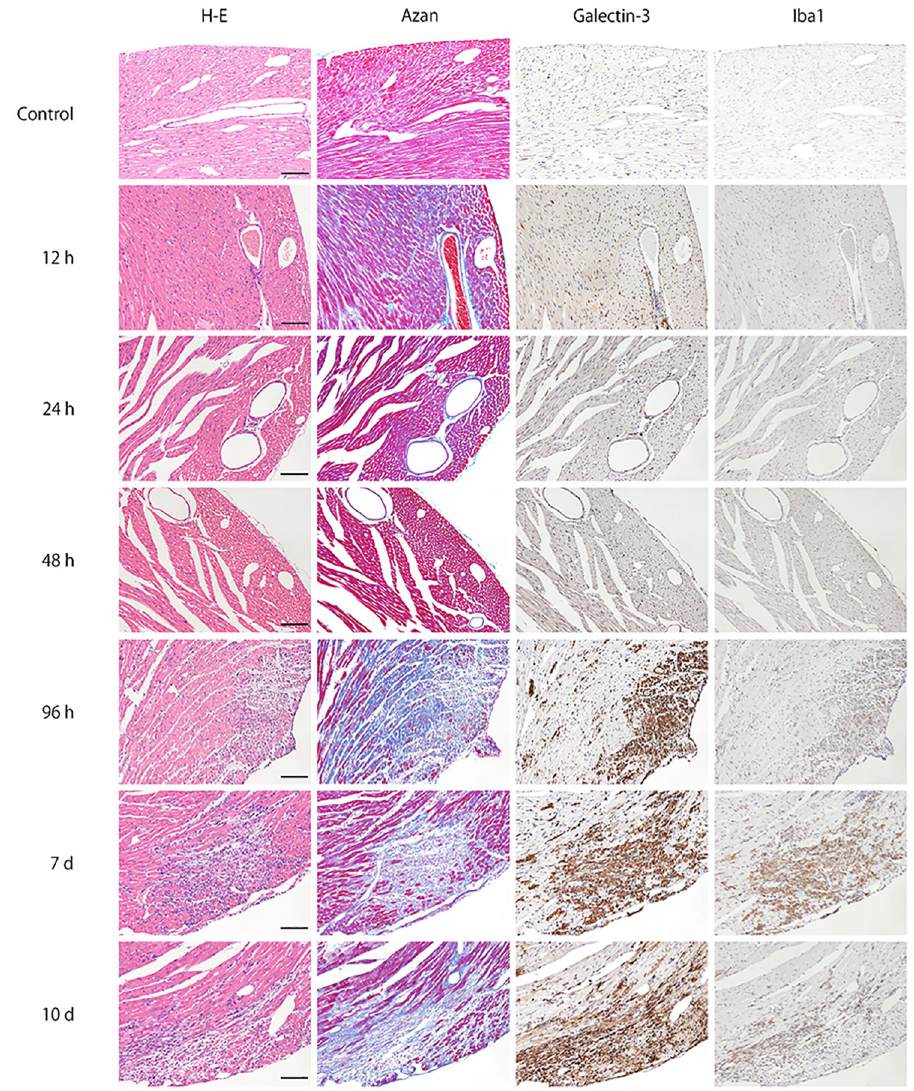
Fig 1. Time-course of representative microphotographs of H&E staining, Azan staining for fibrotic lesions, and immunohistochemistry for galectin-3 and Iba1 in heart tissues at 0, 12, 24, 48, 96 hours, 7 and 10 days after intraperitoneal inoculation of EMCV. For both H&E and Azan staining, notable changes was not observed until 48 hours after EMCV inoculation. Infiltration of inflammatory cells and fibrosis was observed 96 hours after inoculation. Inflammation and fibrosis peaked at 7 days after inoculation. At 0, 12 and 24 hours, there were no galectin-3 and Iba1-positive cell in heart tissues. At 48 hours after EMCV inoculation, interstitial infiltration of a few cells was detected by both galectin-3 and Iba1 immunohistochemistry, and this infiltration was greater at 96 hours. It peaked on day 7 and was observed until day 10. Scale bar = 100 μ m. inoculation (n = 5 at each time point; total n = 30) are shown in Fig 1. Notable changes were not observed until 48 hours after EMCV inoculation, in both H&E staining and Azan staining. Infiltration of inflammatory cells in myocardial tissues was observed at 96 hours after inocula- tion. Inflammation and fibrosis peaked at 7 days after inoculation. In immunostaining, there were no galectin-3 and Iba1-positive cells in heart tissues at 0, 12 and 24 hours. At 48 hours after EMCV inoculation, interstitial infiltration of a few cells were detected by both galectin-3